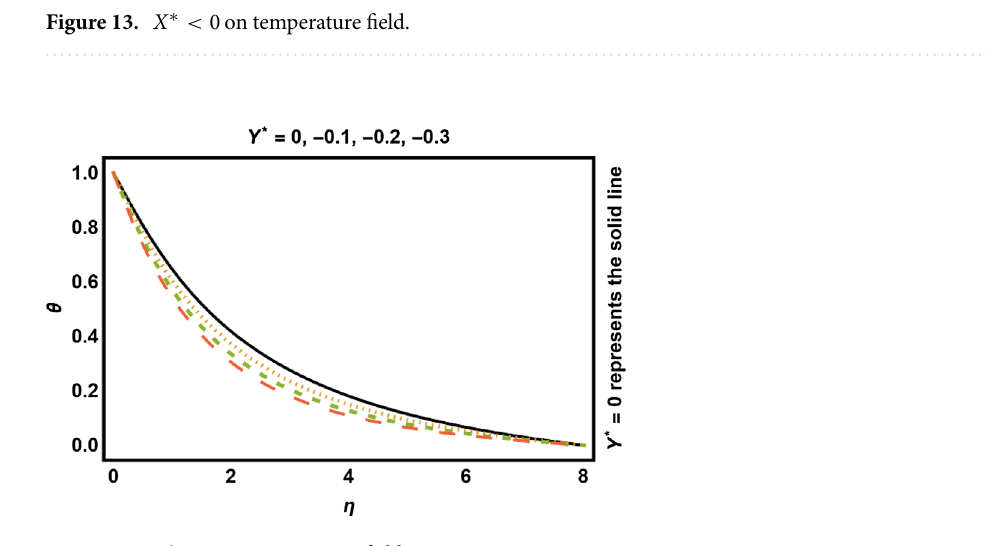
Figure 14. Y ∗ < 0 on temperature field.